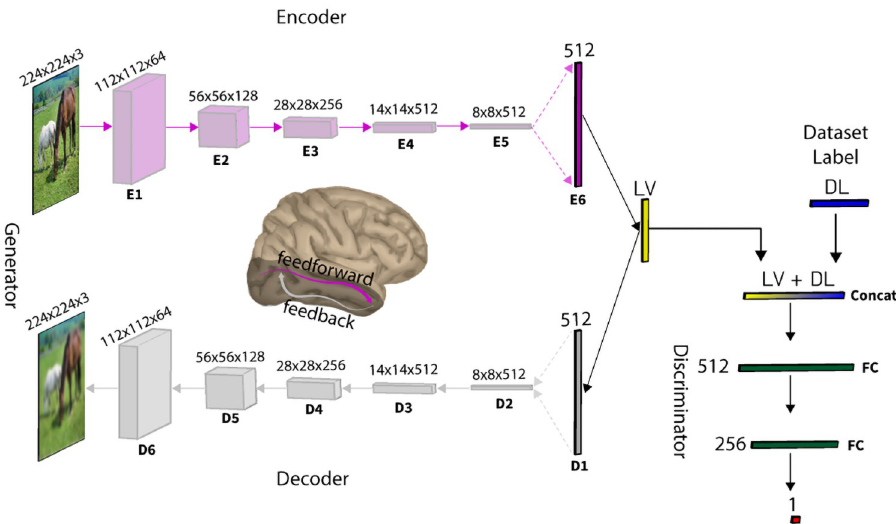
Fig 1. Computational model architecture. The model is a generative adverserial network. The generator is an autoencoder consisting of five convolutional blocks (E1-E5) and one fully connected layer (E6) in the encoder and one fully connected layer (D1) followed by five deconvolutional blocks in the decoder (D2-D6). Each convolutional block encompasses batch normalization, convolution, nonlinear activation function (Leaky Rectified Linear Unit), and pooling operations. Alternatively, each deconvolutional block encompasses batch normalization, transposed convolution, nonlinear activation function (Leaky Rectified Linear Unit), and upsampling operations. The discriminator consists of two fully connected layers. The training Data set consists of 1,980,000 images organized into four super-ordinate categories: (i) Faces, (ii) Animates, (iii) Objects, (iv) Scenes. LV denotes the latent vector generated by the encoder and DL is a one-hot data set label (one of the four mentioned training data sets). Both vectors are concatenated and fed to the discriminator, while only the latent vector is fed to the decoder.